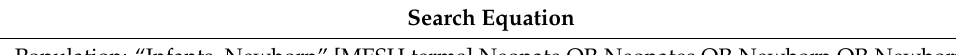
Table 1. Search equation to perform the review. July/2021.